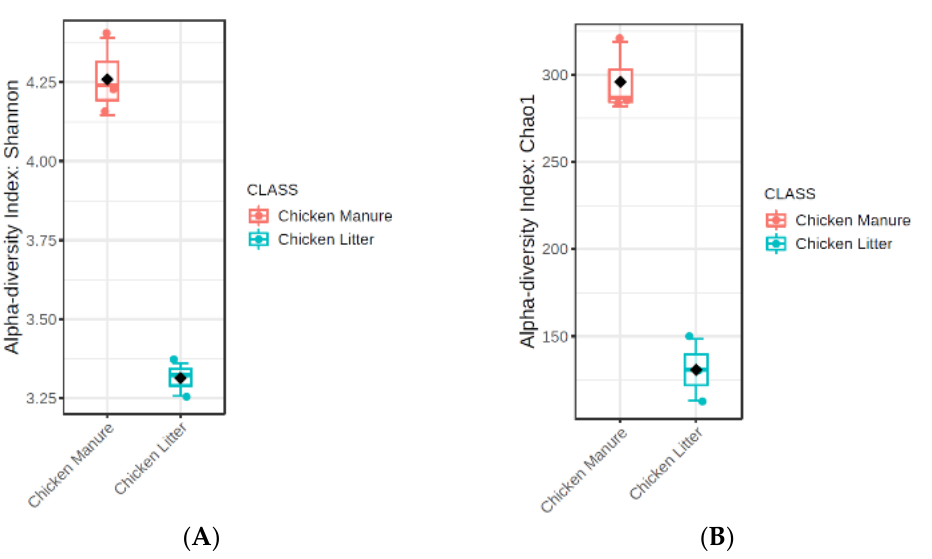
Figure 3. ( A ) Shannon indexes of microbial community diversity p ≤ 0.1; statistical analyses were performed with the Mann – Whitney test ( B ). Chao 1 indexes of microbial community richness, p ≤ 0.1; statistical analysis was performed with the Mann – Whitney test in collected chicken waste sam- ples (chicken manure: CM_1, CM_2, CM_3 (orange dots) and chicken litter: CL_1, CL_2, CL_3 (blue dots)).